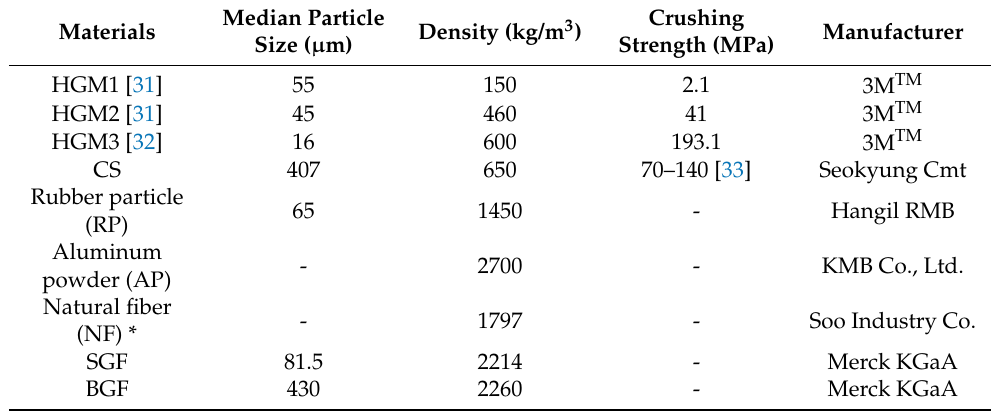
Table 2. Physical properties of